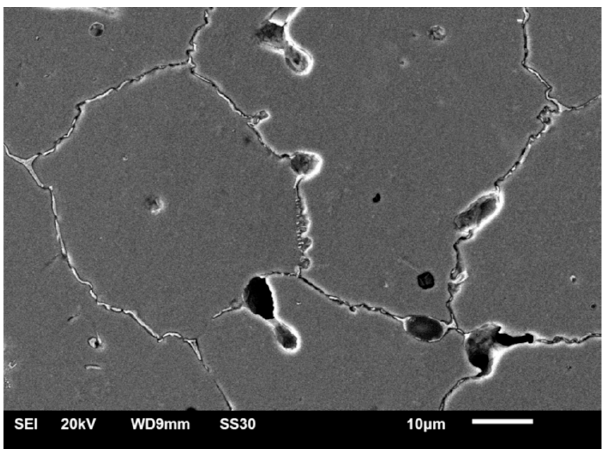
Figure 6. SEM-SE surface morphology of casted MC-HT (×500).